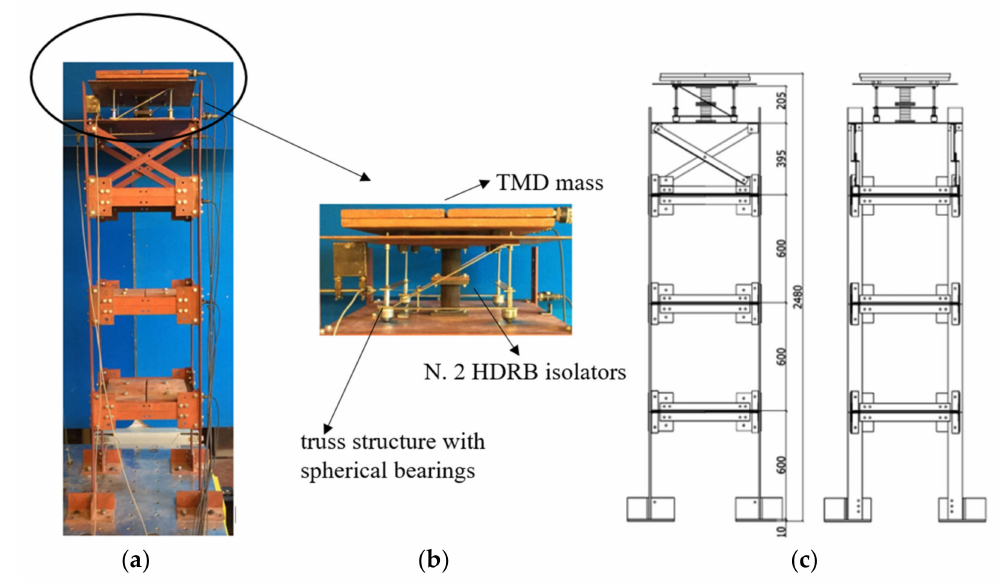
Figure 3. Three-story frame structure with support plane and non-conventional TMD, configuration FTMD: ( a ) physical model, ( b ) detail of the non-conventional TMD, ( c ) vertical sections, dimensions in millimeters.